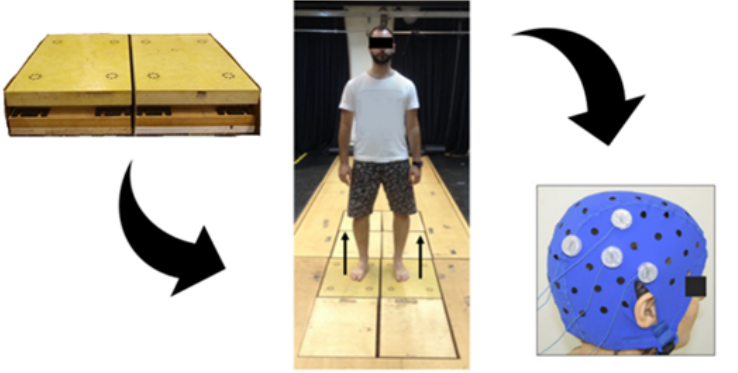
Figure 1. Illustration of the WBA study protocol. The left-hand side figure exhibits the platforms. In the middle, an illustration of a participant positioned on this equipment. The right-hand side shows the position of the high definition transcranial stimulation (HD-tDCS)